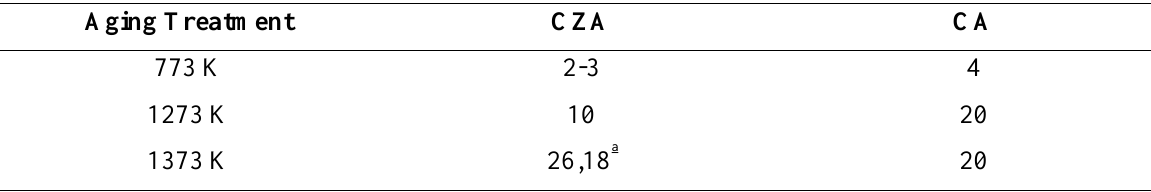
Table 1 Average particle size (measured by TEM, in nm) of the promoter component in CZA and CA specimens after aging treatments under